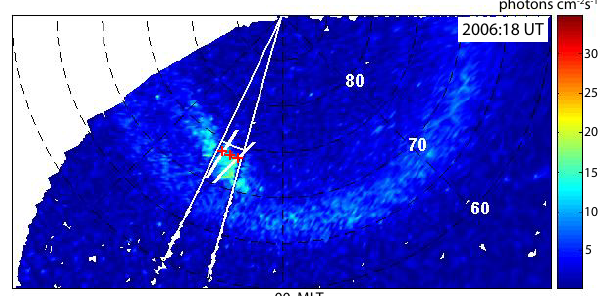
Fig. 3. UV image taken at 20:06:18UT on 25 November 2000. The PAE boundary is marked by a white longitudinal arc connecting the white 40-min MLT sector boundaries. The EISCAT PCBs are marked by red crosses (both beams and their